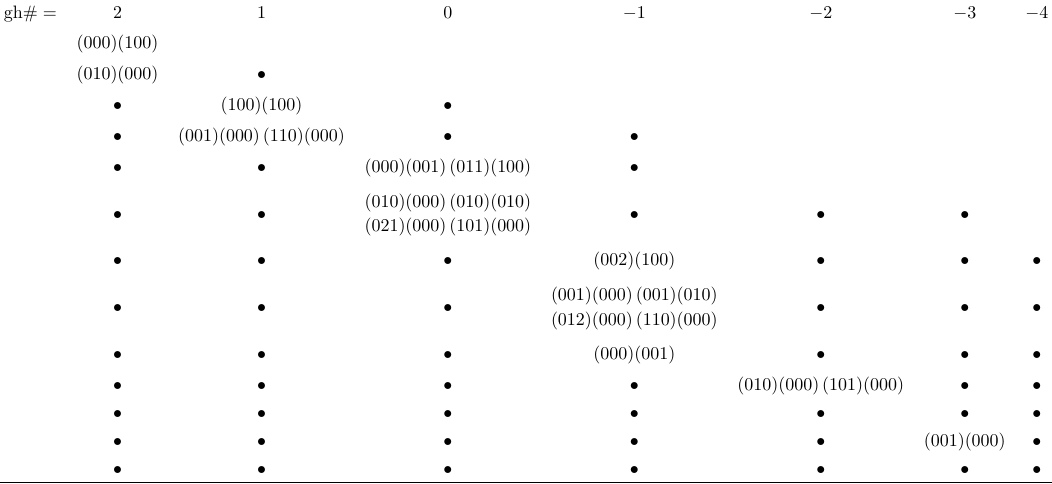
Table 3 . The zero-mode cohomology for the N = (3 , 0) gravitino